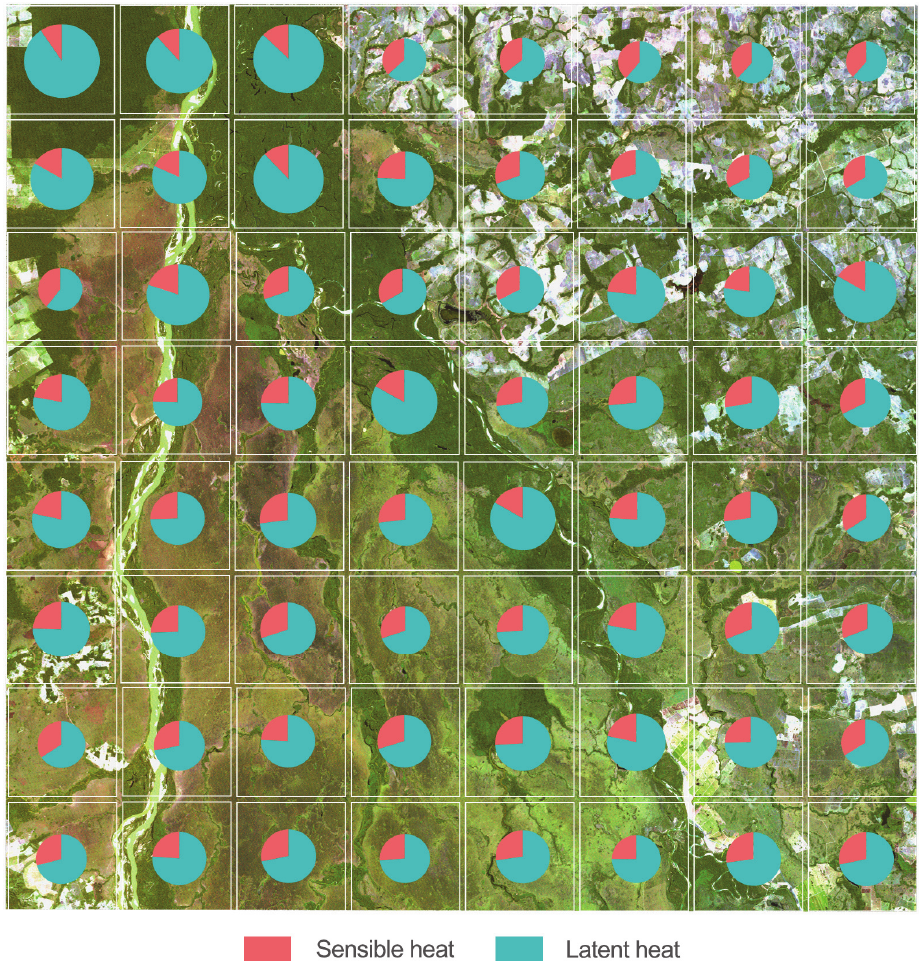
Figure 8. Average surface-energy-fluxes partitioning between sensible ( H ) and latent ( LE ) heat according to changes in vegetation physiognomies using SEBAL-T results with g Ts 4 quantile for the year 2004 DOY 200.